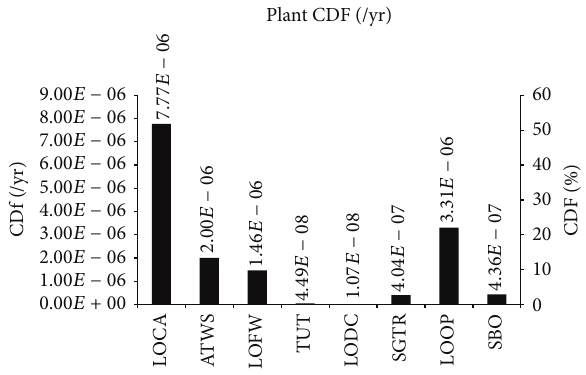
Figure 3: CDF for internal initiating